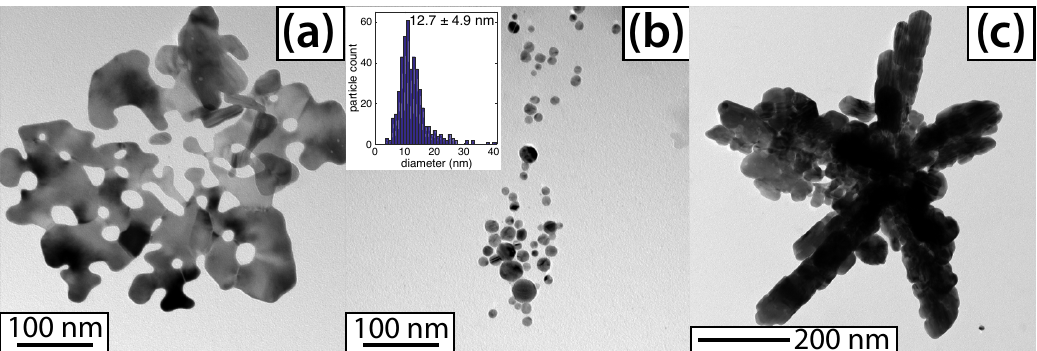
Figure 5. Transmission electron microscopy (TEM) images of silver nanoparticles, with ( a ) 0.25; ( b ) 1; and ( c ) 10 mM NH . Histogram overlay corresponds to ( b 3